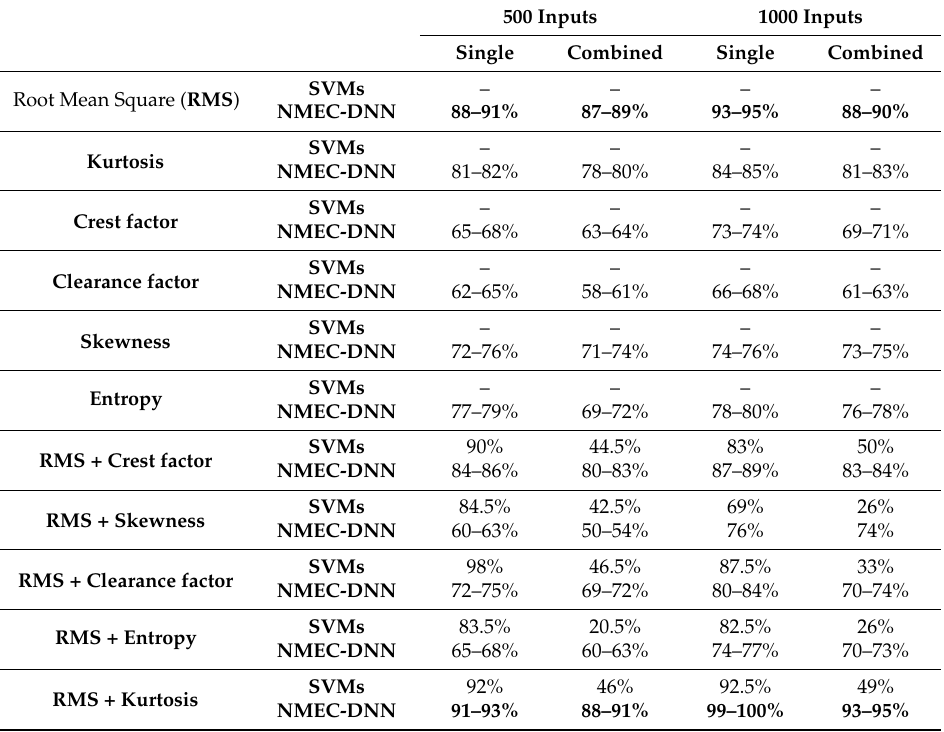
Table 2. Results of